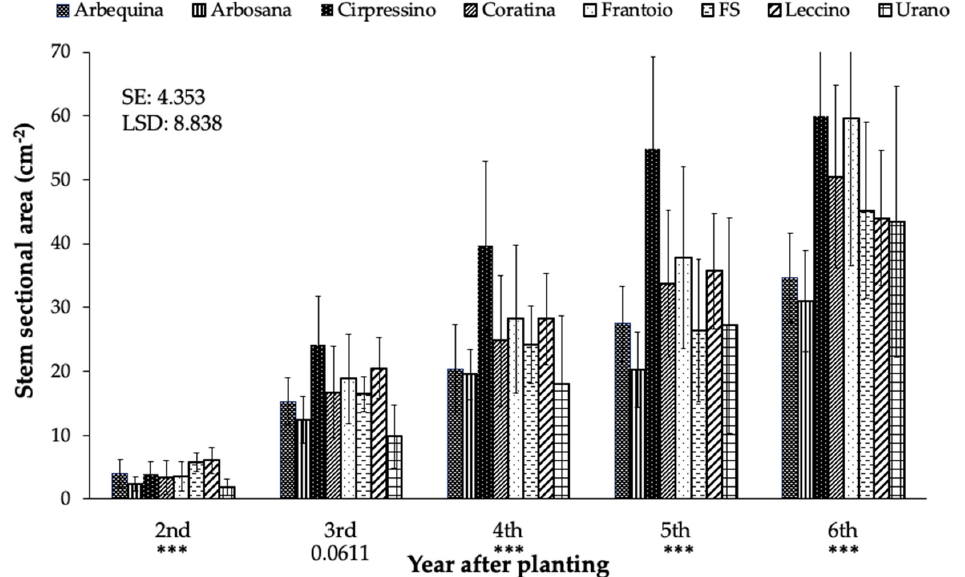
Figure 3. Effect of cultivar on stem sectional area (A, cm 2 ) for each year. Standard error (SE) of the mean difference and least significant difference (LSD) ( p < 0.001) are reported. Bars in each column indicate the standard deviation. *** means p < 0.001. Table 2. Matrix correlation (Person correlation) among growth parameters of all cultivars. p -values: *** p < 0.001.